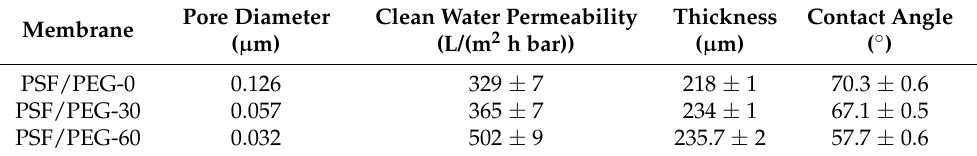
Table 1. Properties of membrane samples.